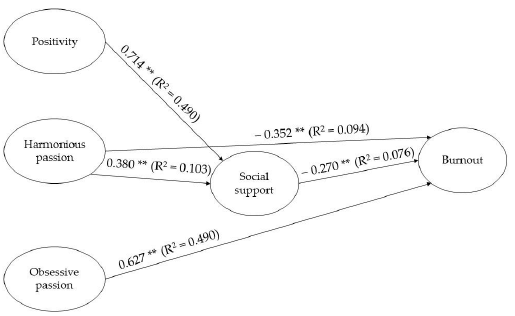
Figure 2. Structural model of positivity, passion, social support and burnout. Note: ** p < 0.001; * p <